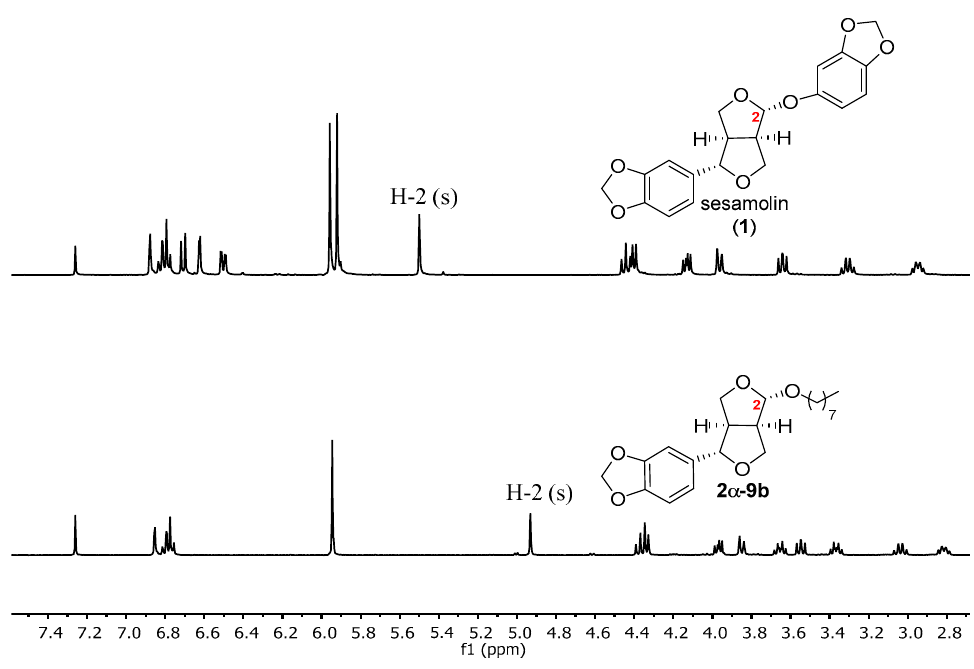
Figure 4. 1 H NMR spectra of sesamolin ( 1 ) ( top ) and 2 α -9b ( bottom ).